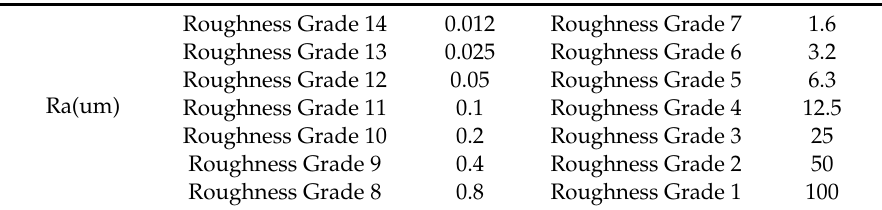
Table 5. Roughness classification.